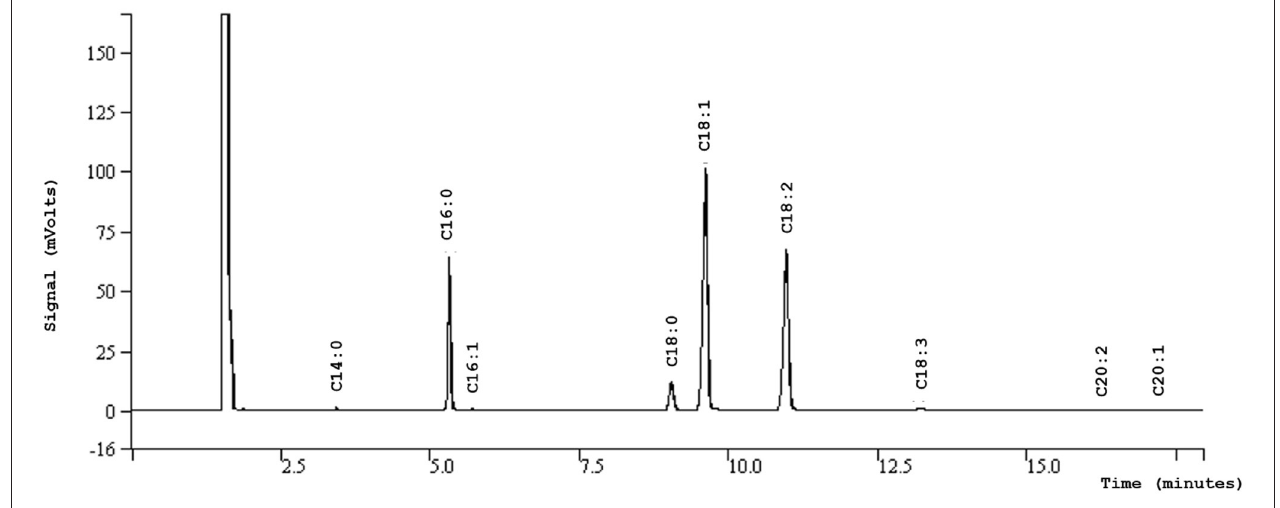
FIGURE 2 | GC chromatogram of argan oil fatty acids.